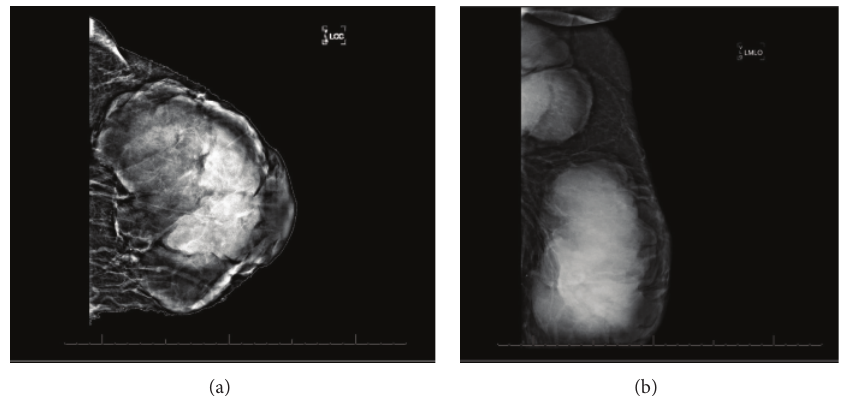
Figure 2: Breast Mammogram. (a) A large, hyperdense lobular shaped mass with smooth margins in the left breast, measuring 19 × 14 × 17cm. (b) Left axilla showing a 6cm large abnormal lymph node mass.